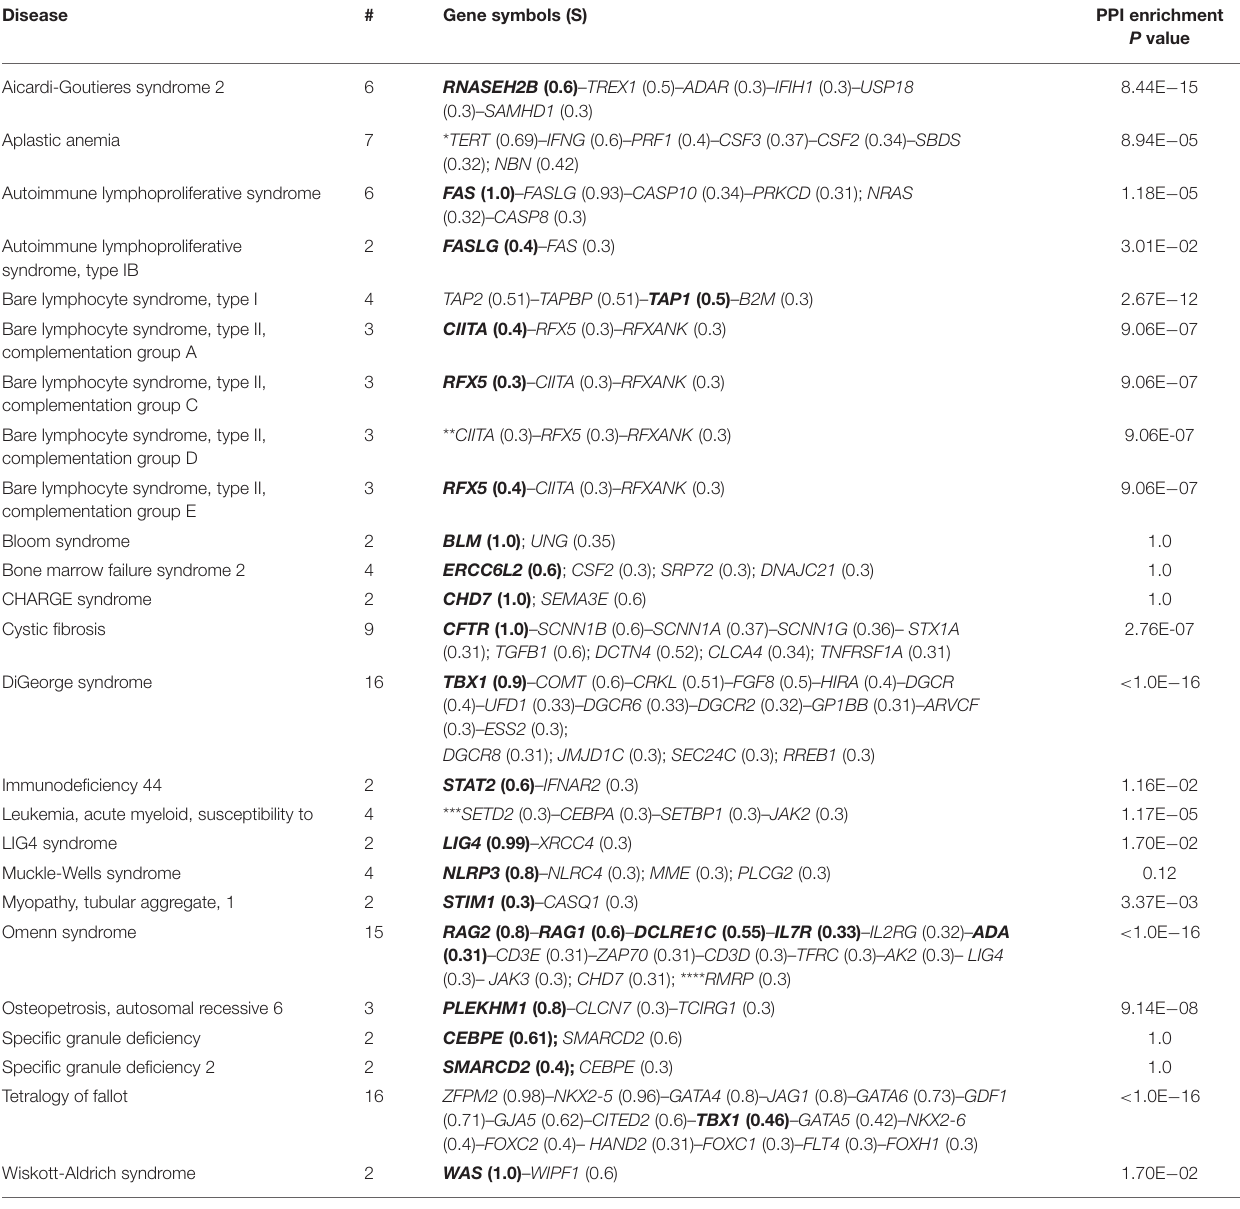
TABLE 1 | IUIS/OMIM diseases with more than one high-score gene-disease association in the DisGeNET database.